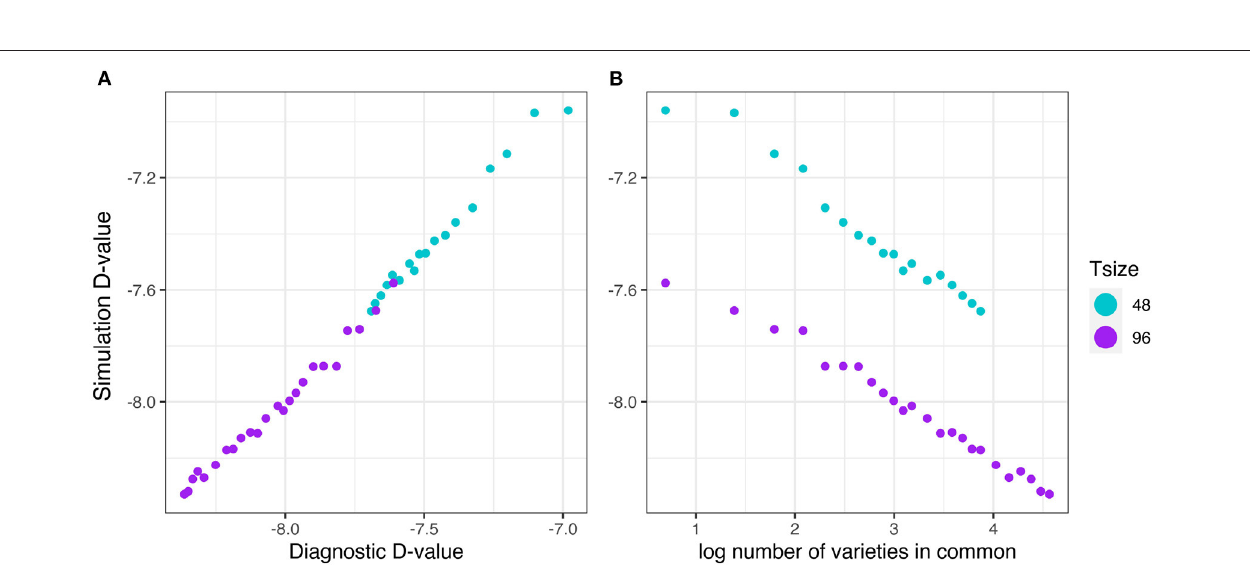
Frontiers in Plant Science |